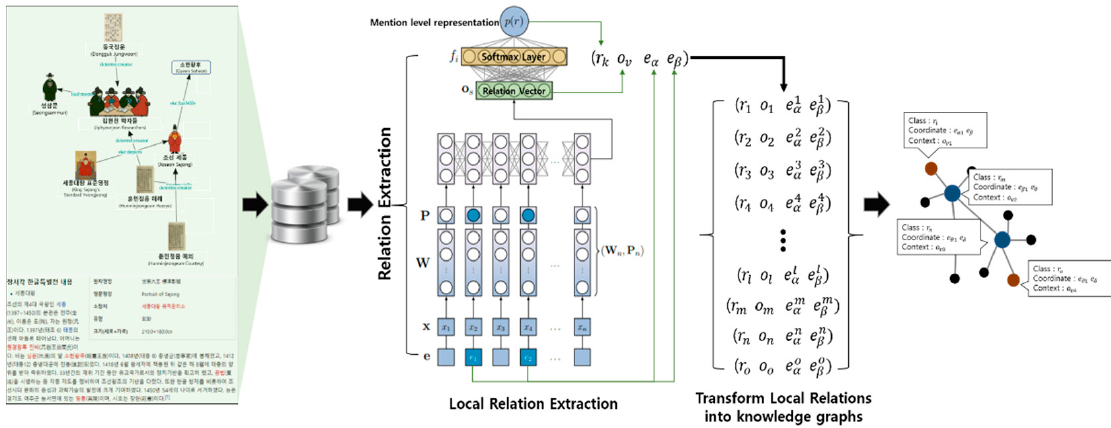
Figure 3. Structure of Content Triple Auto Generation.